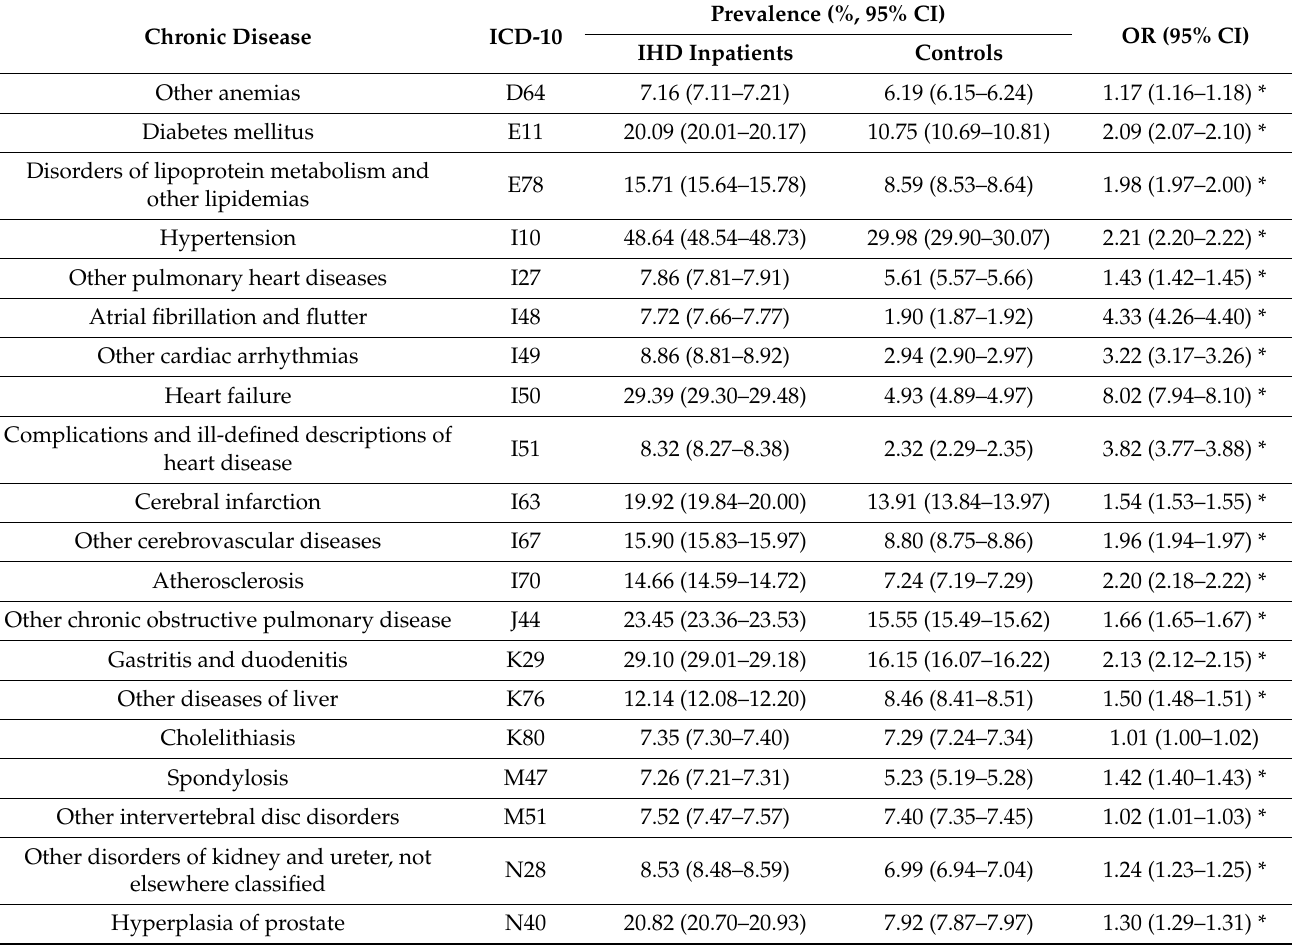
Table 1. Prevalence of the top 20 comorbid chronic diseases in cases and their ORs (95%